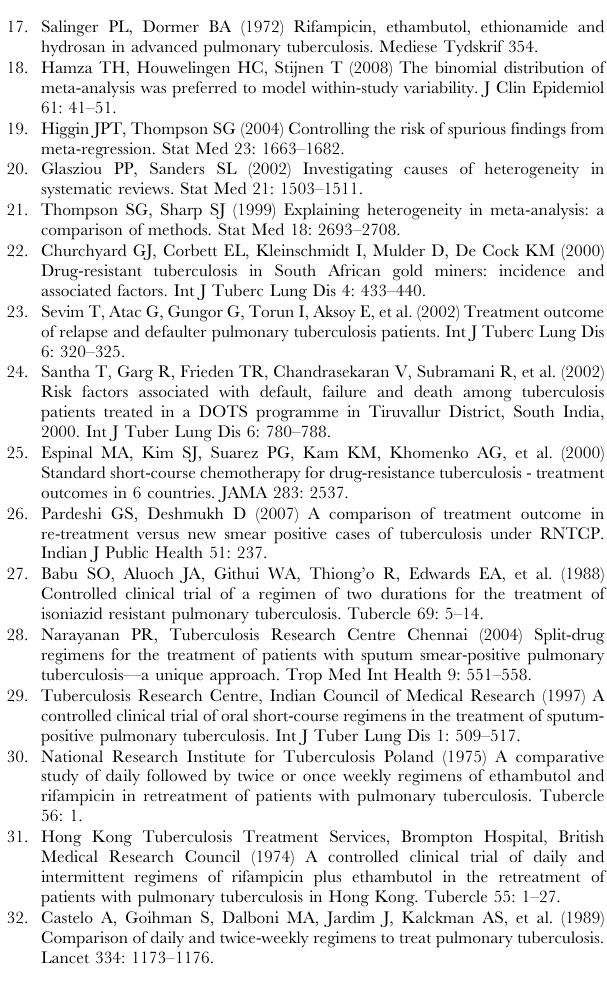
Figure S1 Relapse rates. (A) Forest plot of relapse rates in trials of patients only with INH resistance. (B) Forest plot of relapse rates in subgroups with INH resistance in trials of previously untreated patients (new cases).